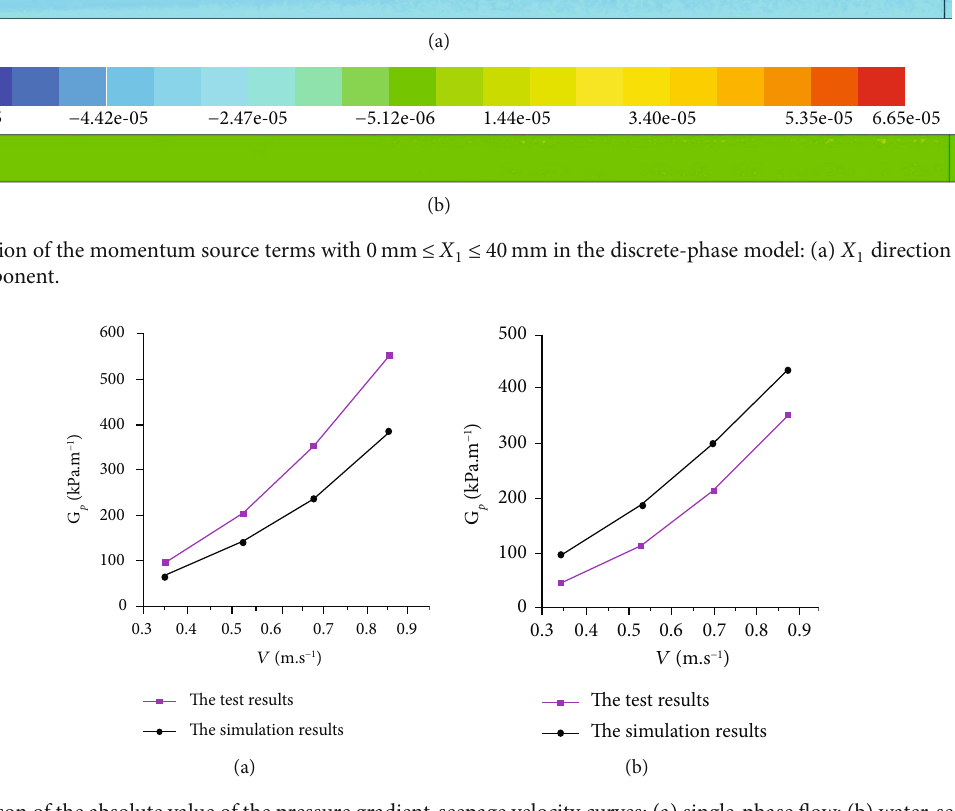
Figure 15: Comparison of the absolute value of the pressure gradient-seepage velocity curves: (a) single-phase fl ow; (b) water-sediment two- phase fl ow.